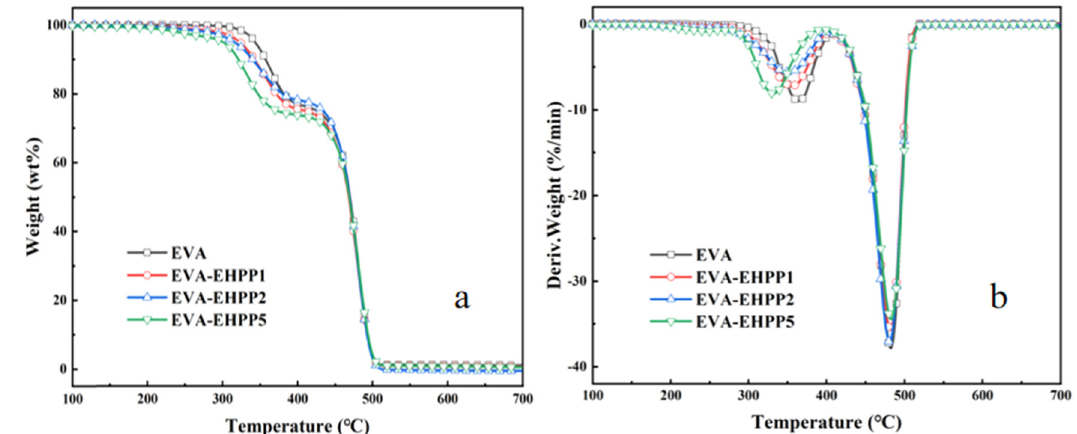
Figure 4: TG ( a ) and DTG ( b ) curves of EVA and its composites under nitrogen